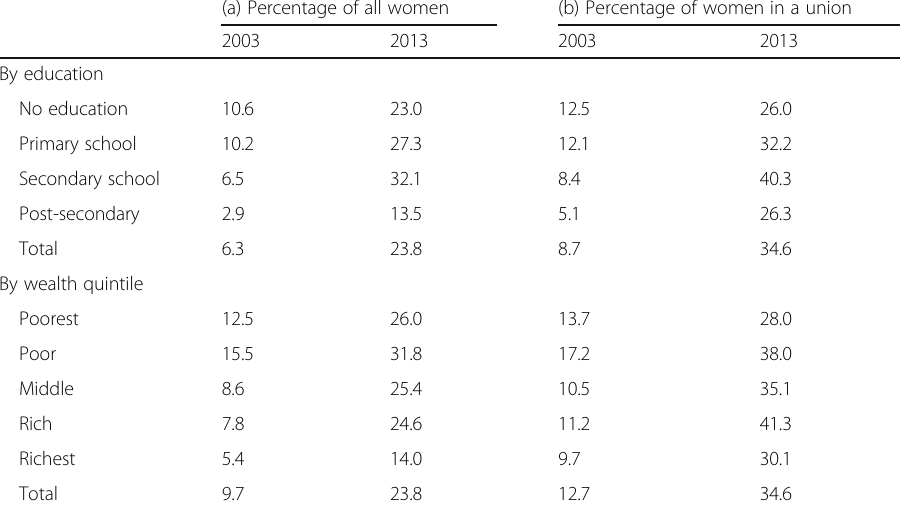
Source: Courtesy of Brienna Perelli-Harris on the basis of the Demographic and Health Survey data 2003 and